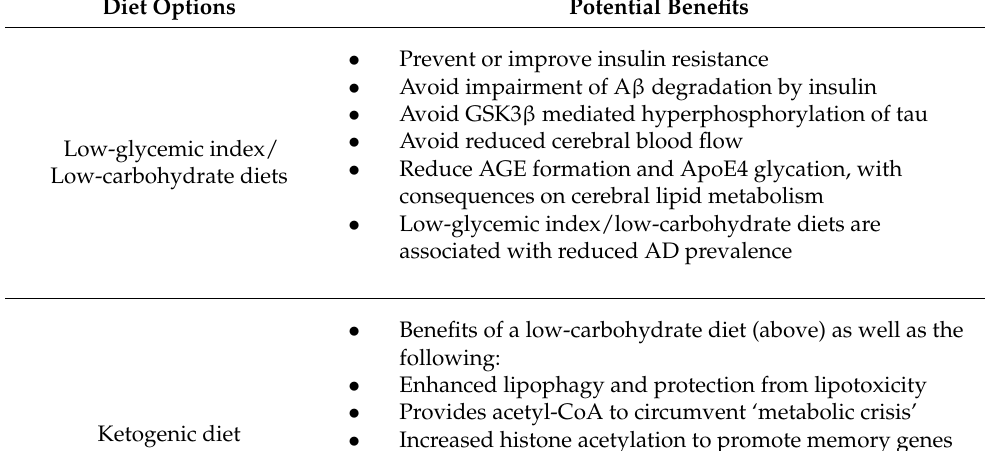
Table 1. Dietary options and